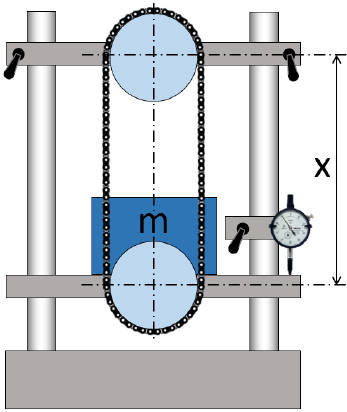
Figure 2. Chain elongation measurement